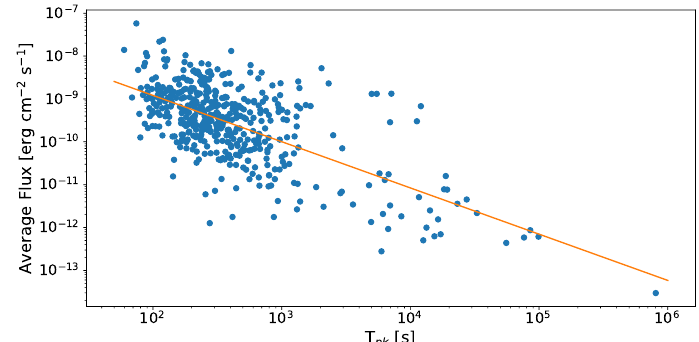
Figure 6. Average fluxes of Swift-XRT flares in the 0.3–10 keV energy range versus peak times T pk . The blue points are the 468 flares observed by Swift from April 2005 to March 2015 (collected from [87]). The orange line is the resulting linear regression, which gives the expression: log F av = − 6.76 − 1.08 × log T pk